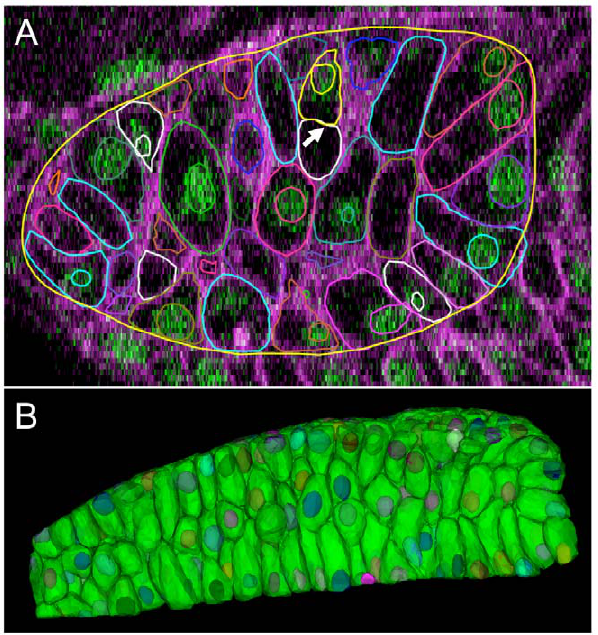
Figure 8. Robust correspondence between membrane and nuclear segmentations. Algorithm performance was assessed by matching automated segmentations obtained from the nuclear and membrane channels. In the ideal case, each individual nucleus would match with a unique membrane and vice-versa. (A) A single 2D image plane is shown with contours of membrane and nuclear segmentations overlaid on raw data. Some cells have their corresponding nuclei located out-of-plane. The lack of a one-to-one correspondence indicates an error. For example, an over-segmentation of the membrane channel (white arrow) causes one of the membrane components to not contain a nucleus. (B) 3D renderings of cells from membrane and nuclear segmentations.